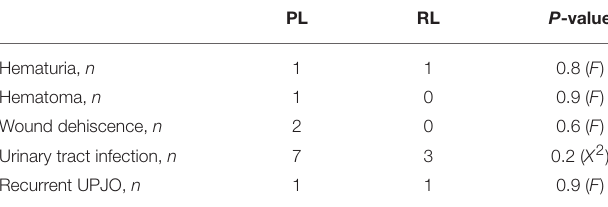
TABLE 4 | Postoperative complications. PL RL P